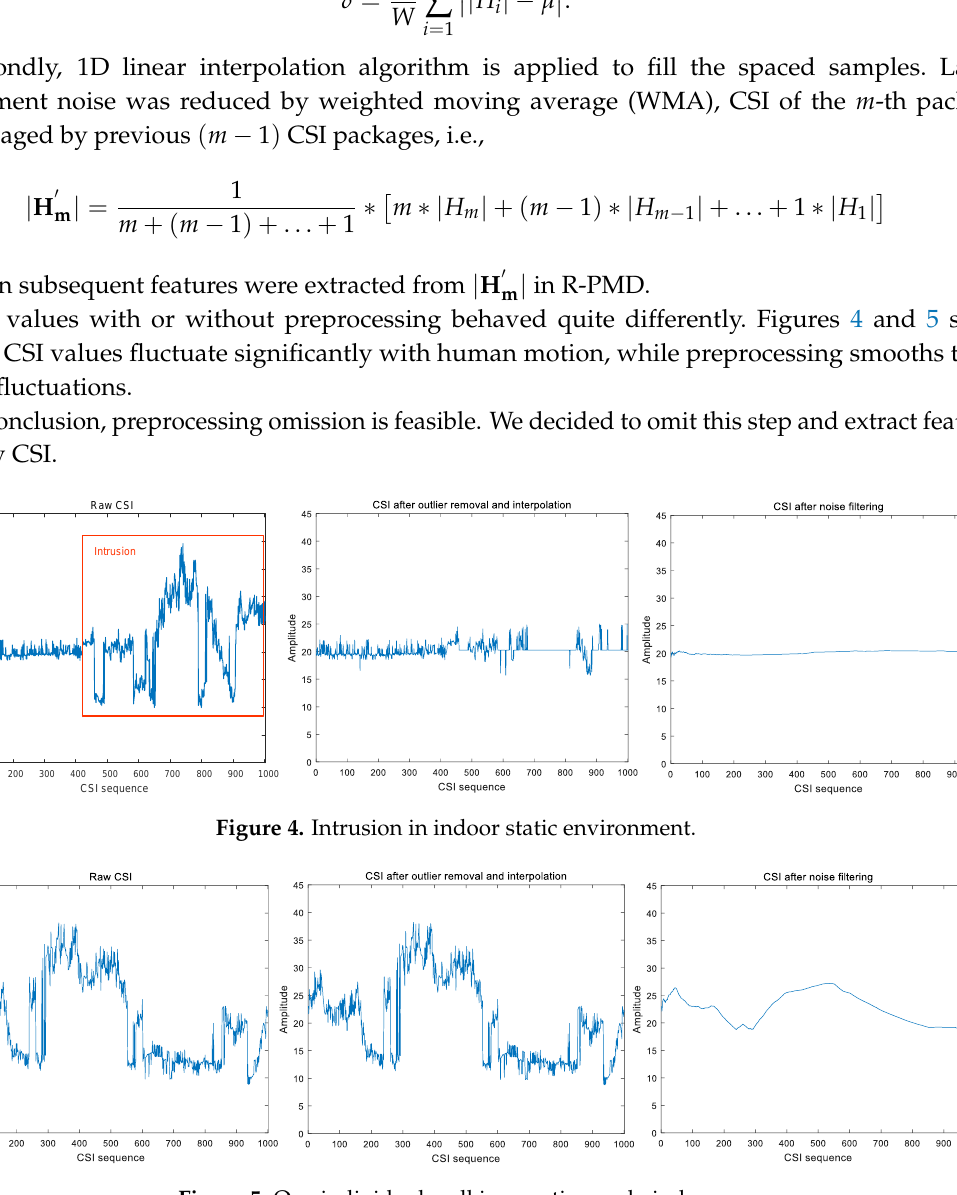
Figure 5. One individual walking continuously